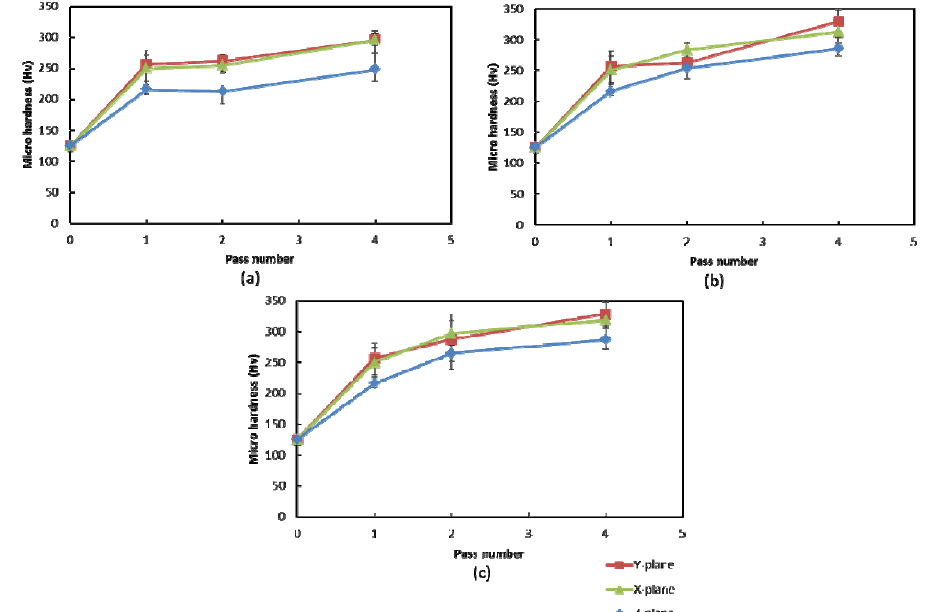
Figure 5. Microhardness after ECAP for low CN Fe-20%Cr alloy with ( a ) route A, ( b ) route Bc and ( c ) route